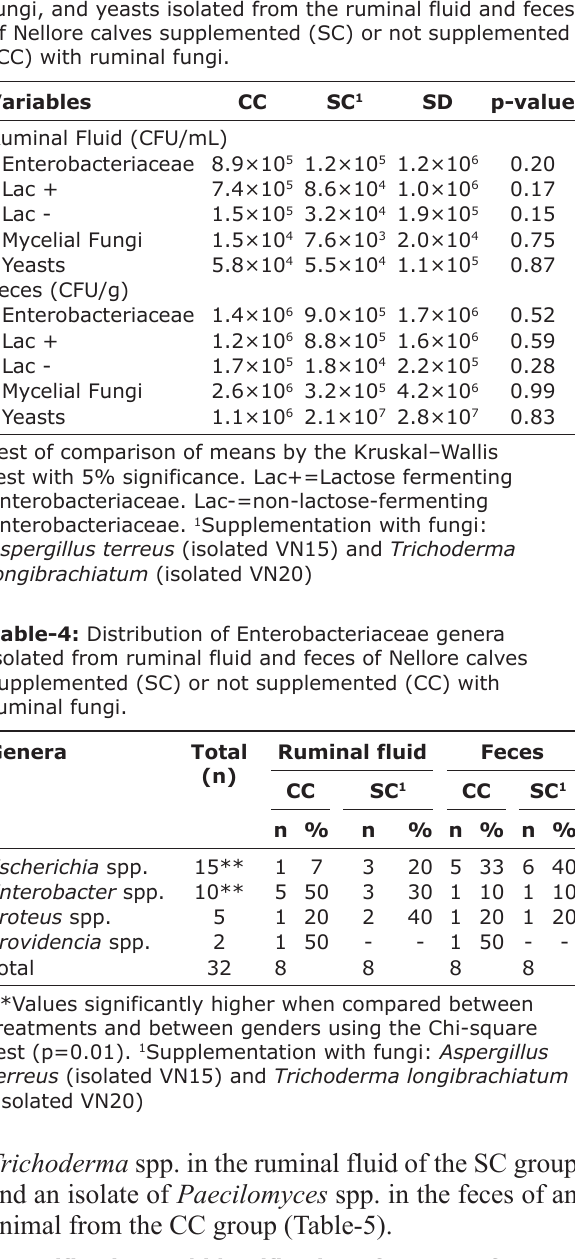
Table-3: Means of colony-forming units (CFU) and standard deviations (SD) of Enterobacteriaceae, mycelial fungi, and yeasts isolated from the ruminal fluid and feces of Nellore calves supplemented (SC) or not supplemented (CC) with ruminal fungi.